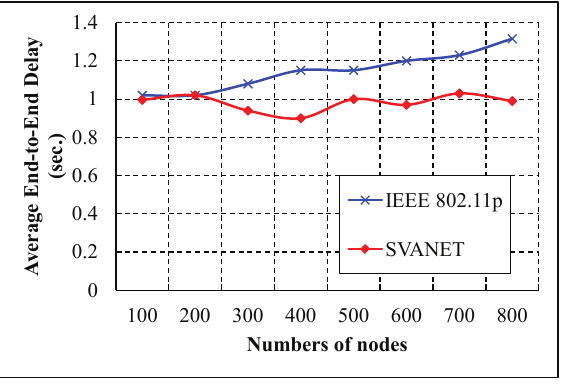
Figure 19. Average end-to-end delays in the highway with eight